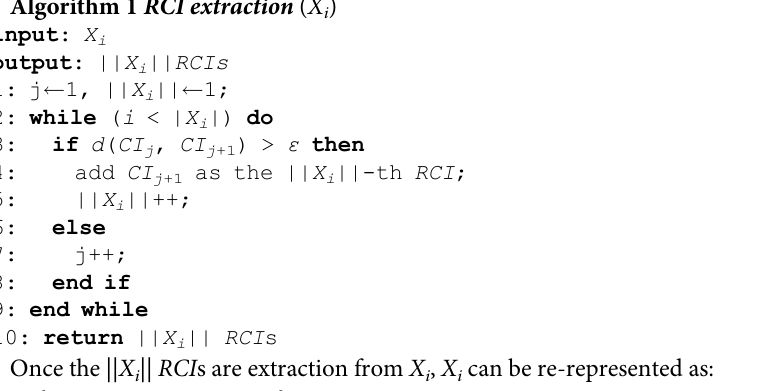
Algorithm 1 RCI extraction ( X